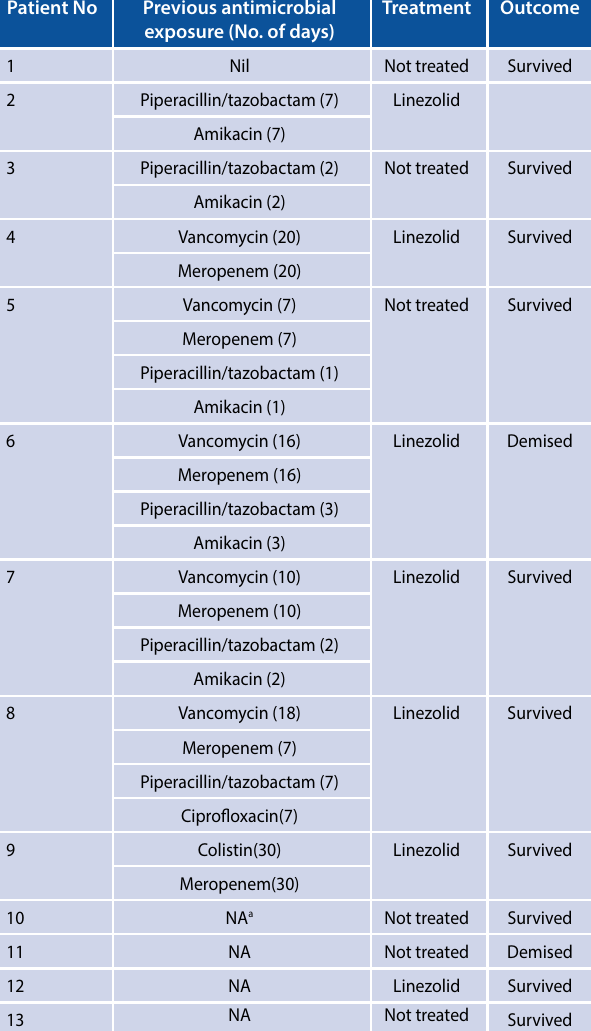
a NA = not available.